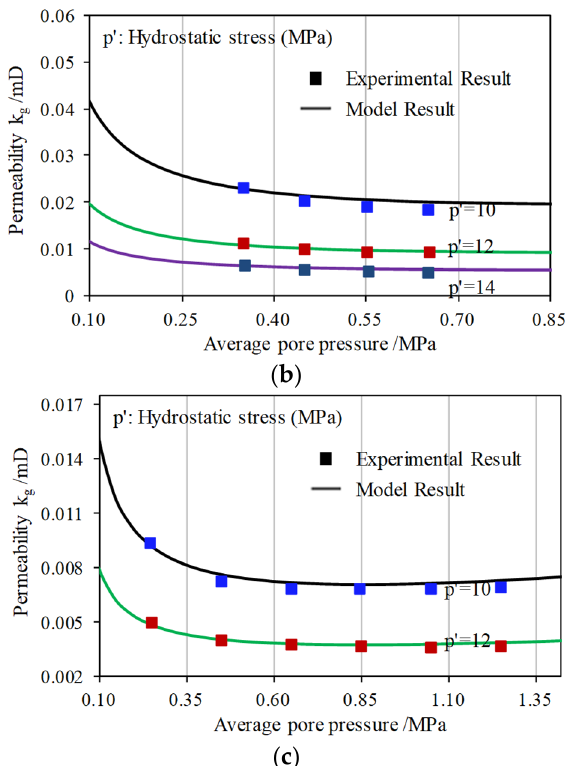
Figure 7. Comparison between the experimental data and model calculation. ( a ) Sample M1, ( b ) Sample M2, ( c ) Sample M3.